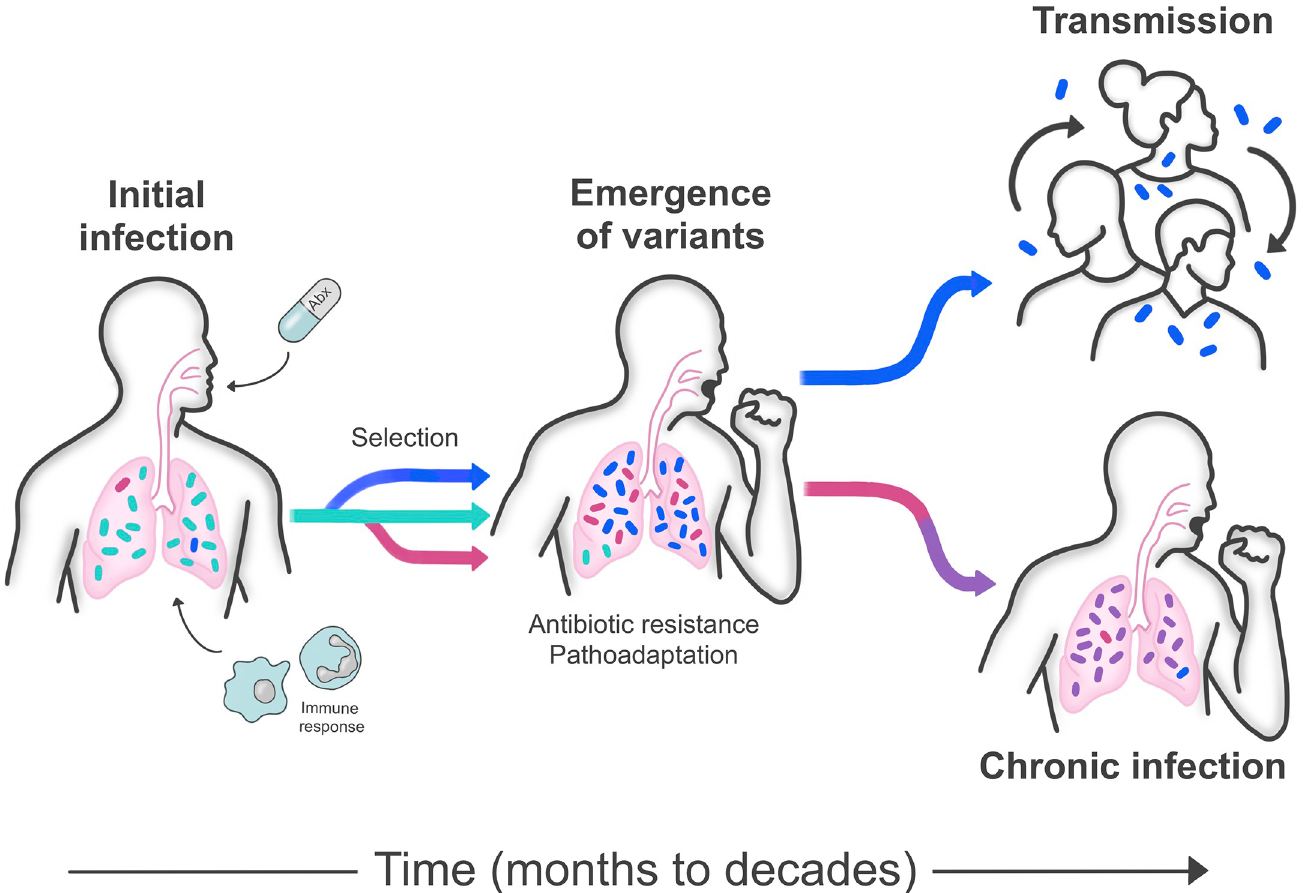
Fig 2. Bacterial evolution during chronic infection. Pulmonary infection is shown as an example. Infection starts with a population of bacteria entering a new environment, such as the lung. Antibiotics, immune responses, and other pressures exert selection on the bacterial population, causing the emergence of bacterial variants possessing antibiotic resistance and other adaptive traits in a process referred to as pathoadaptation. Bacteria from the adapted population can be transmitted to other individuals or can continue to adapt and cause chronic infection, lasting months to decades.